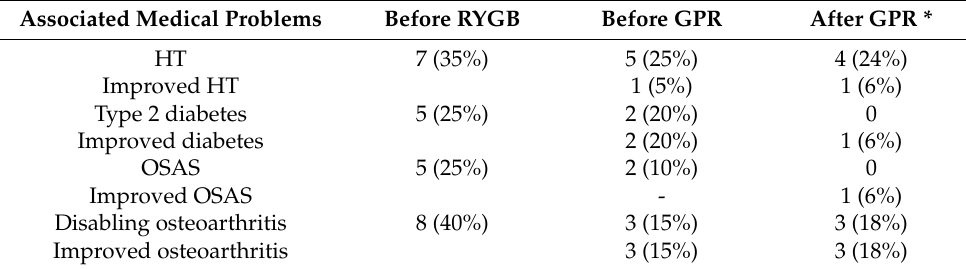
Table 2. Evolution of obesity-associated medical